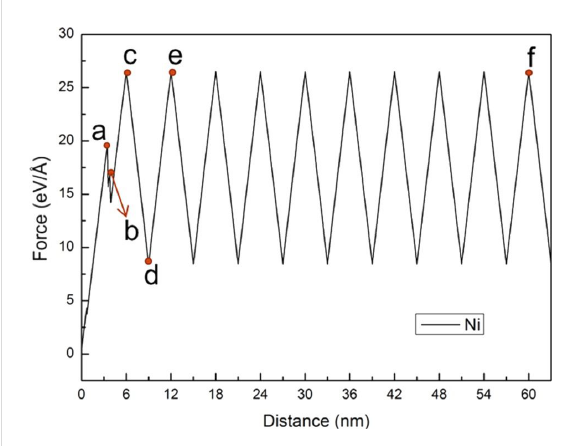
Figure 13: Force–distance curve of Ni under ten times of cyclic loading, where the first shear distance of the sample was 6 nm, and the reverse shear and shear distance were 3 nm. The letters a–f repre- sent the observation positions for the crack growth